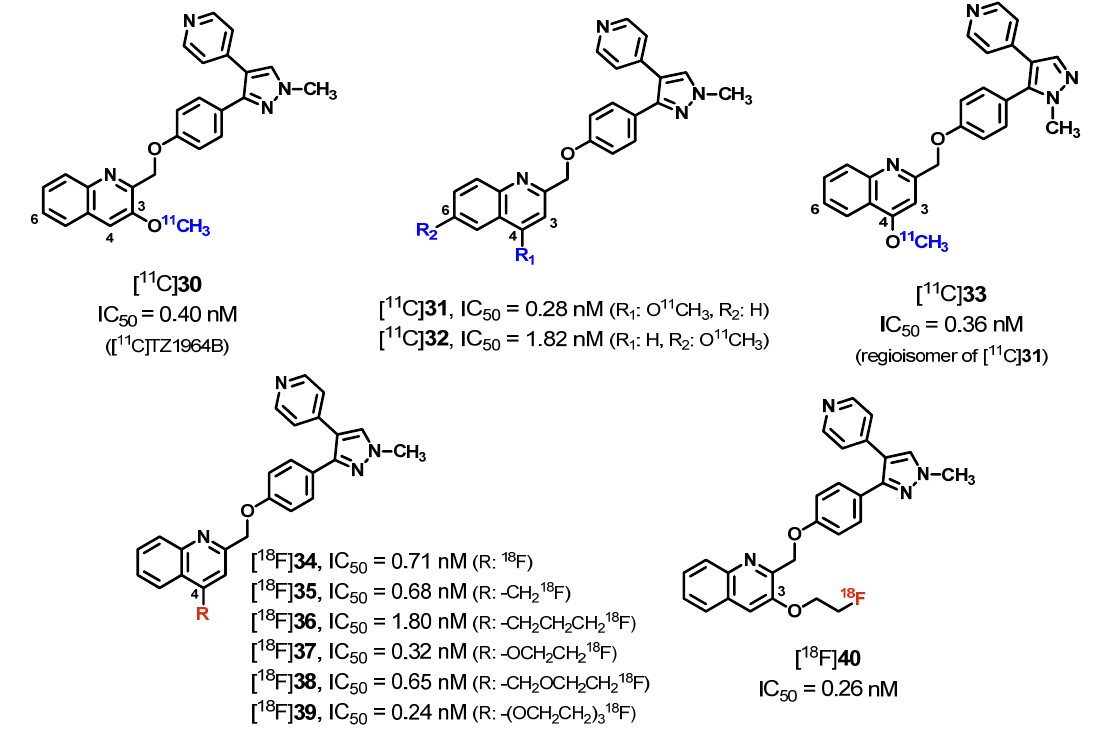
Figure 6. Molecular structures of further 11 C- or 18 F-labeled derivatives of compound 22 as PDE10A radioligands for